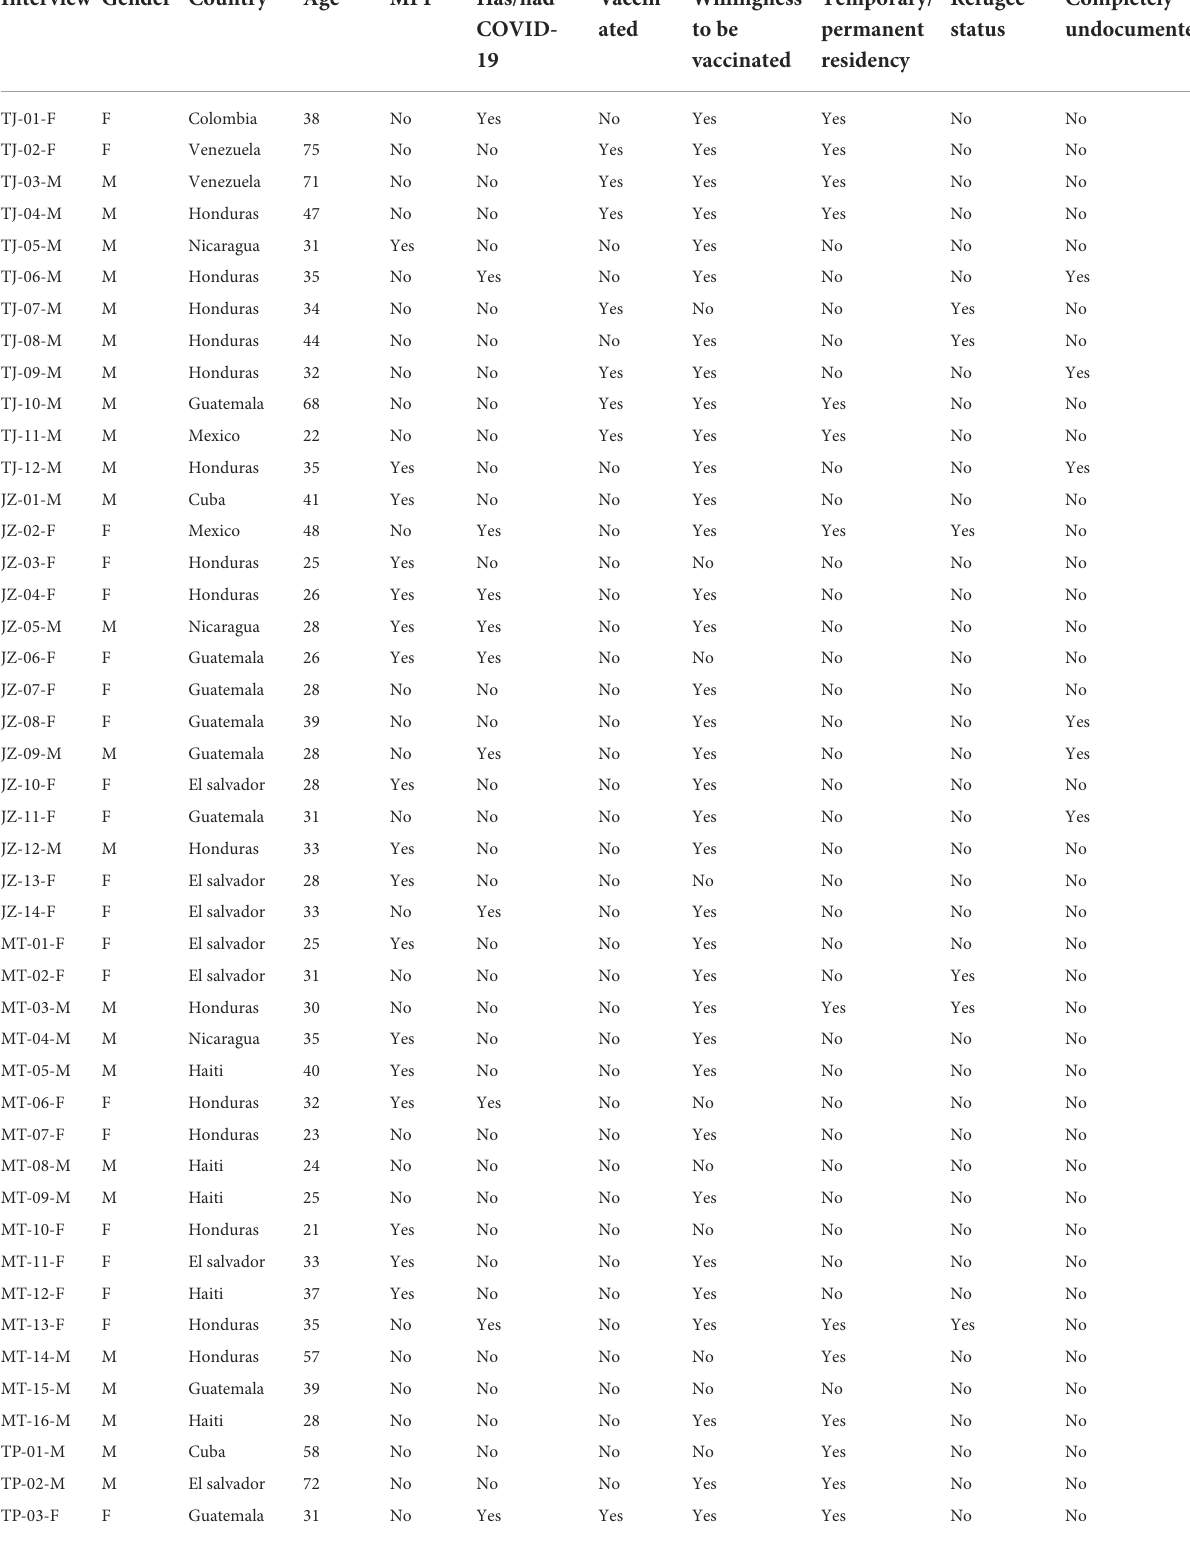
TABLE 1 Migratory and COVID-19 record of the interviewees. Interview Gender